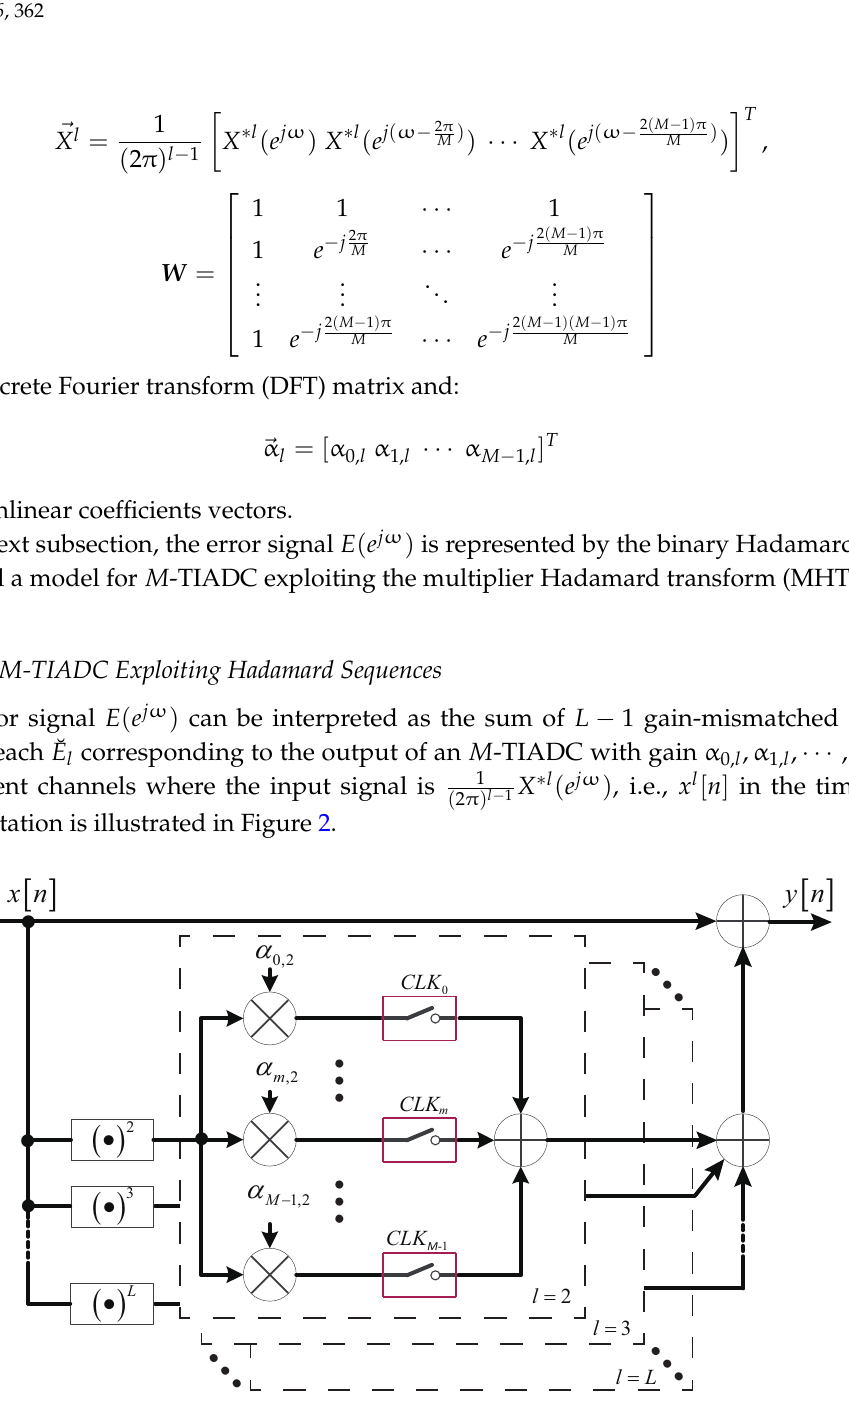
Figure 2. Nonlinear mismatches in the M -time-interleaved analog-to-digital converter (TIADC) are interpreted as the sum of a series of gain-mismatched M